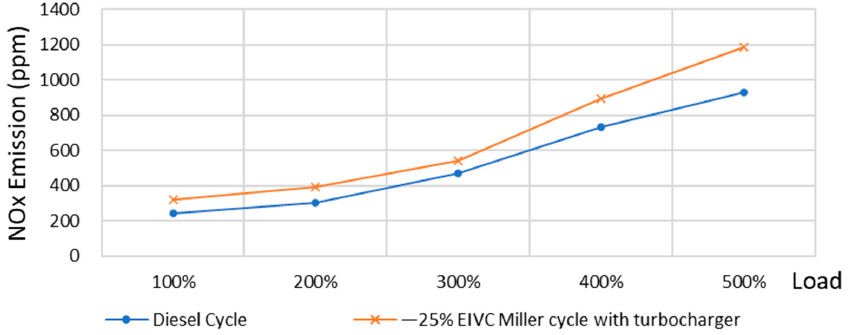
Figure 14. Comparison of NOx between diesel engine and EIVC Miller cycle turbocharger diesel